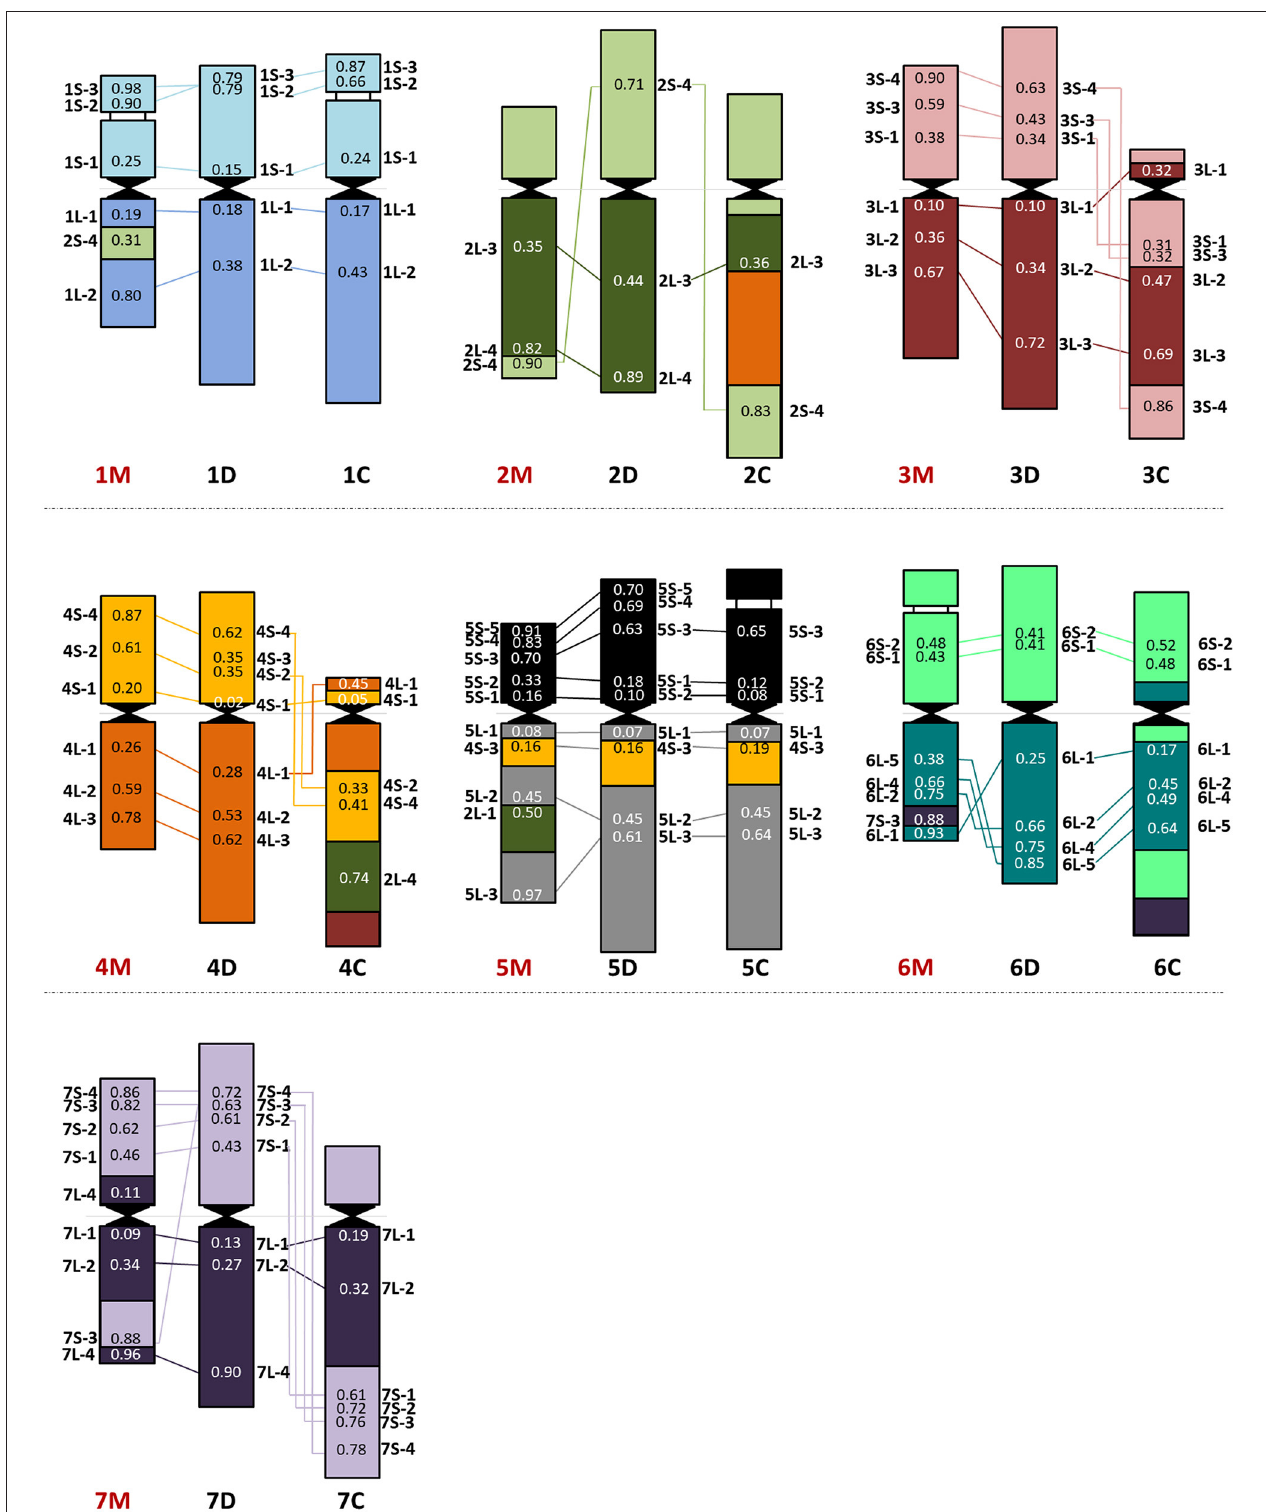
FIGURE 3 | Chromosome organization of the Ae. comosa M genome (left) compared with the D (sub)genome of wheat (middle) and the Ae. markgrafii C genome (right) . The average relative positions of cDNAs are shown on the chromosomes.